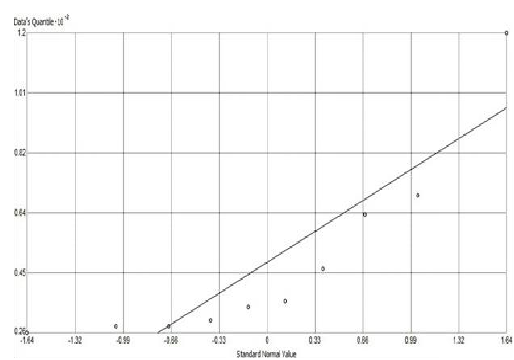
table 1. the statistics of 15 accident-prone intersections in